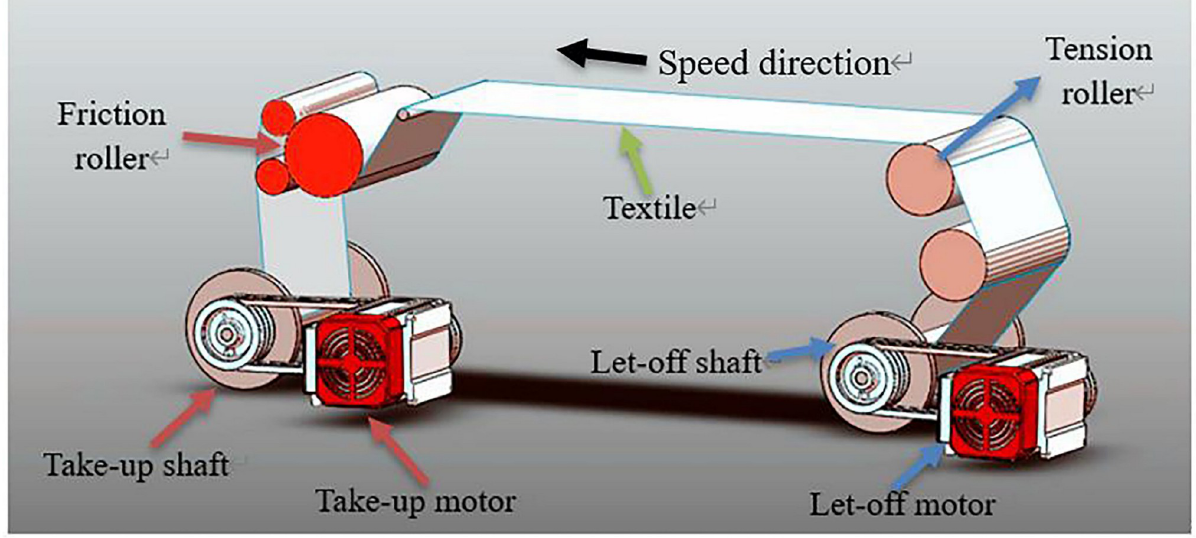
Fig 1. Structure drawing of rapier loom